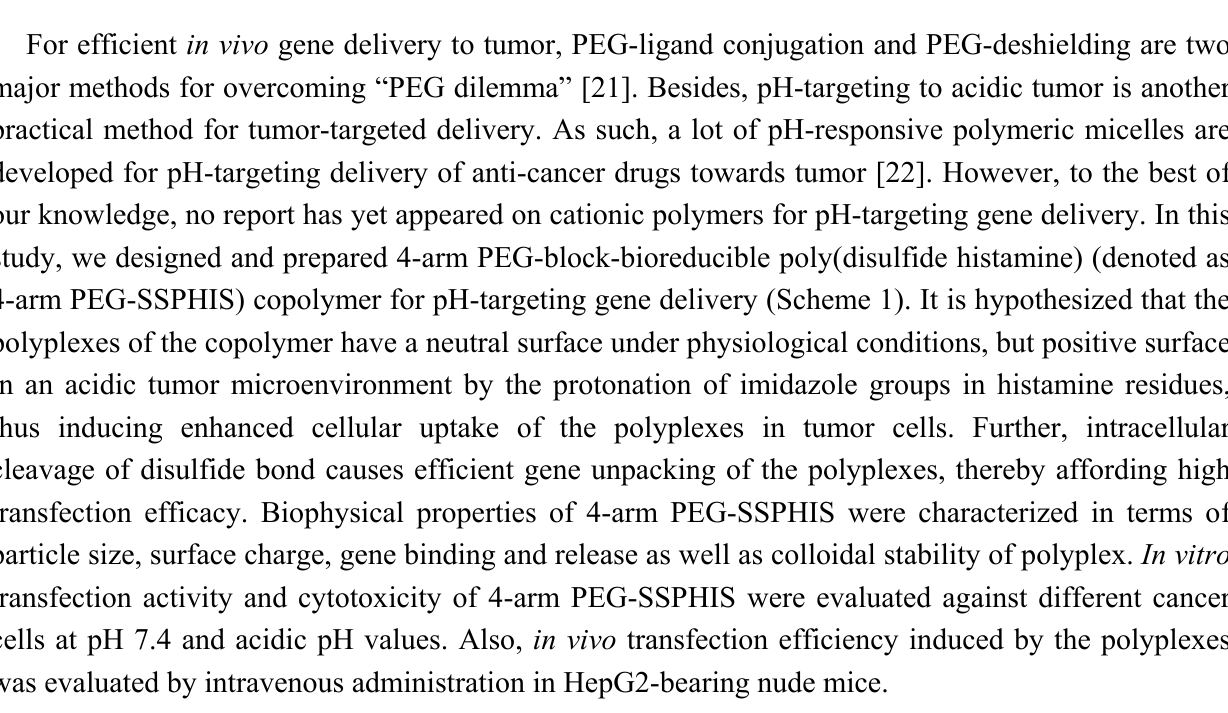
Scheme 1. Schematic illustration of pH-targeting gene delivery towards tumor cells with 4-arm PEG-SSPHIS copolymer as a pH and redox dual responsive gene delivery vector: ( a ) gene binding of 4-arm PEG-SSPHIS copolymer to form the polyplexes with